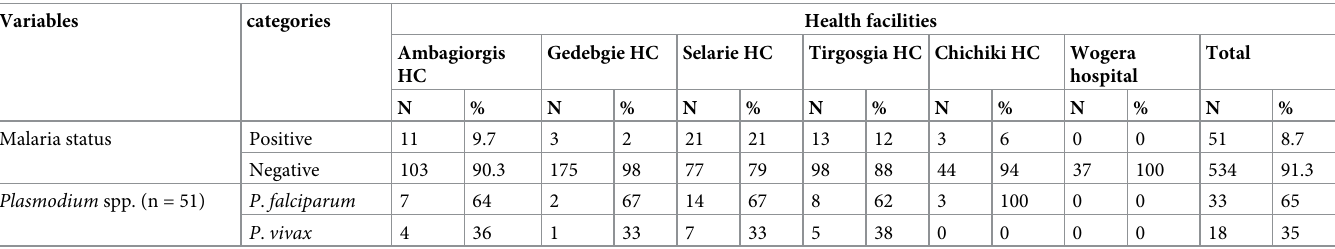
Table 3. Prevalence and distribution of Plasmodium species, Wogera district, northwest Ethiopia, 2017. Variables